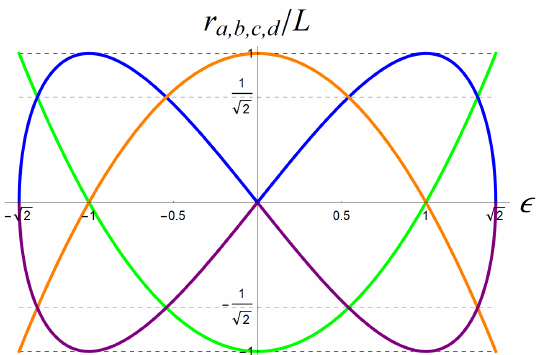
Figure 11: The roots of f ( r ) in units of L as a function of ε for d = 5. The black hole horizon radius r is shown in blue, the cosmological horizon radius r b = − r root r in green and the fourth root r a c